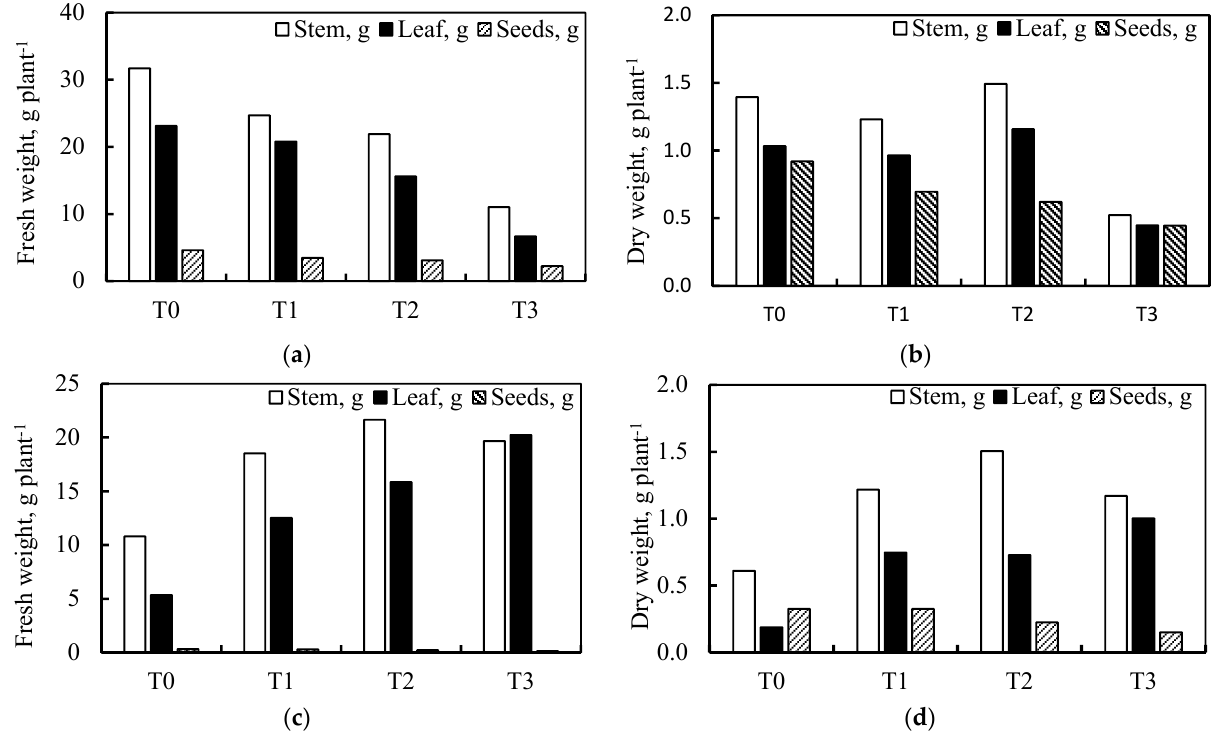
Figure 1. Fresh and dry weight of crops ( a and b first experiment; c and d second experiment).